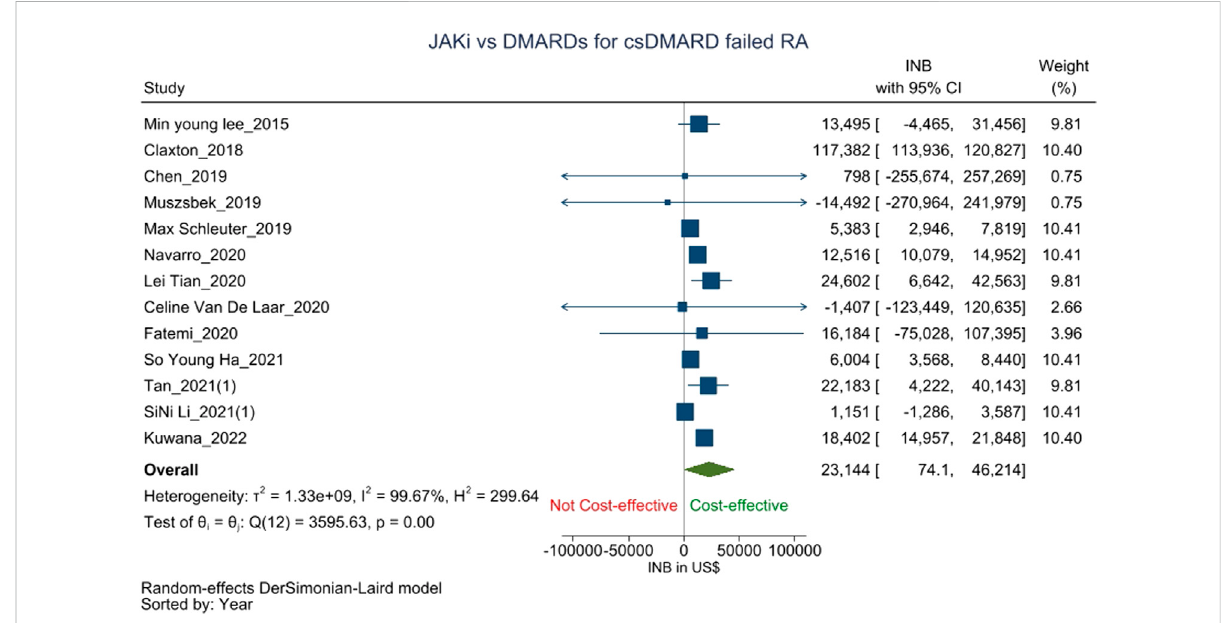
FIGURE 2 ForestplotofmetaanalysisshowingpooledINBswith95percentCIvaluesforJAK-icomparedwithcsDMARDs/bDMARDsforcsDMARDfailed RA